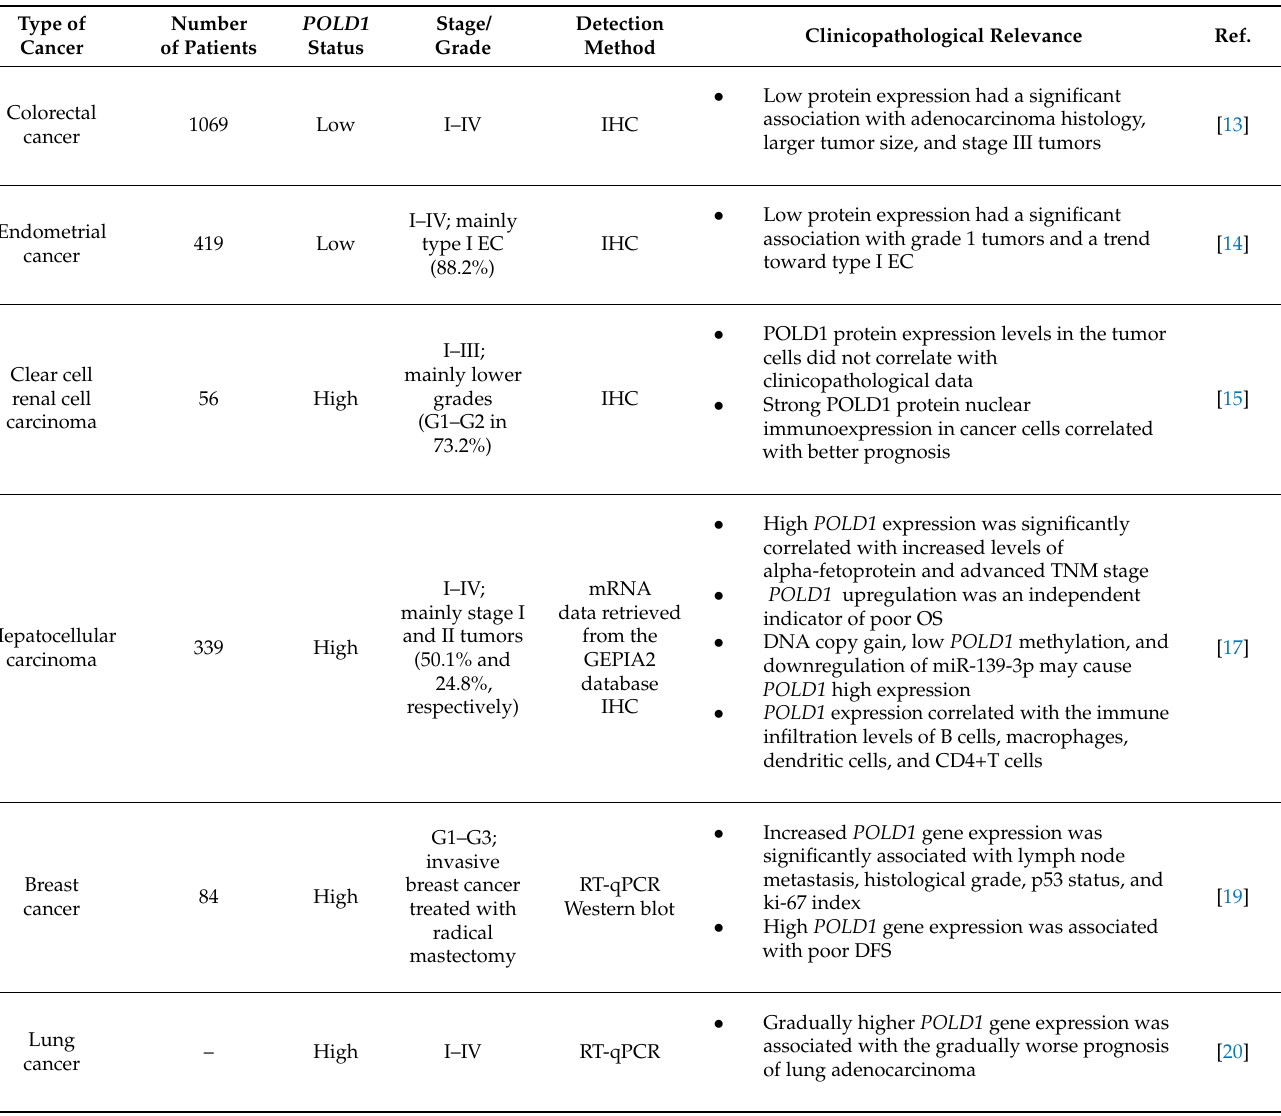
Table 1. Changes in POLD1 expression levels and their implications in different types of